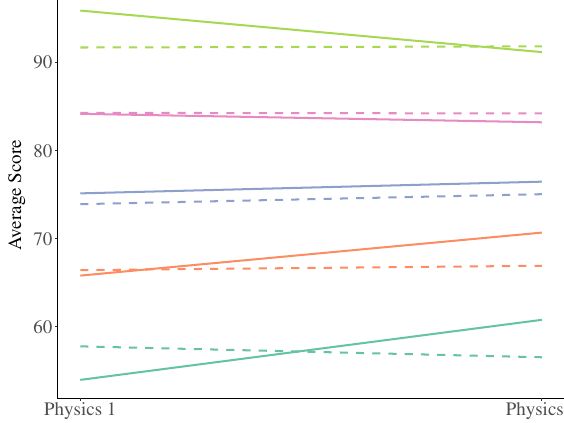
FIG. 1. Average changes in score for A, B, C, D, and F students from the first to the second semester of physics. Student letter grade categories are determined by the first semester physics final exam scores in the solid lines and by the first semester midterm exam scores in the dashed